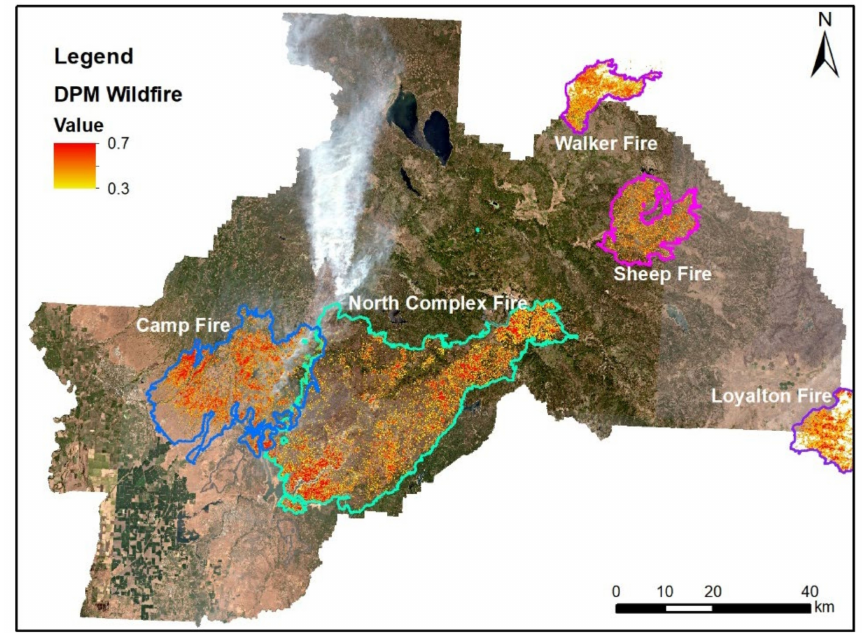
Figure 5. DPM depicting damage area after Camp Fire, Walker Fire, North Complex Fire, and Sheep Fire wildfires. Image from Sentinel-2 data acquired on 17 July 2021, during the Dixie